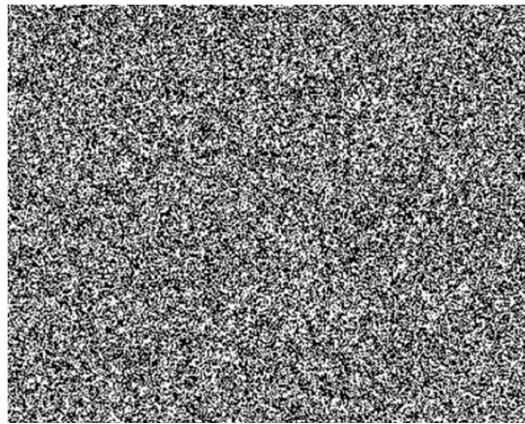
Figure 3. Designed speckle background. Table 1. Parameters of the requirements of the speckle background and the experimental layout. Number Parameters